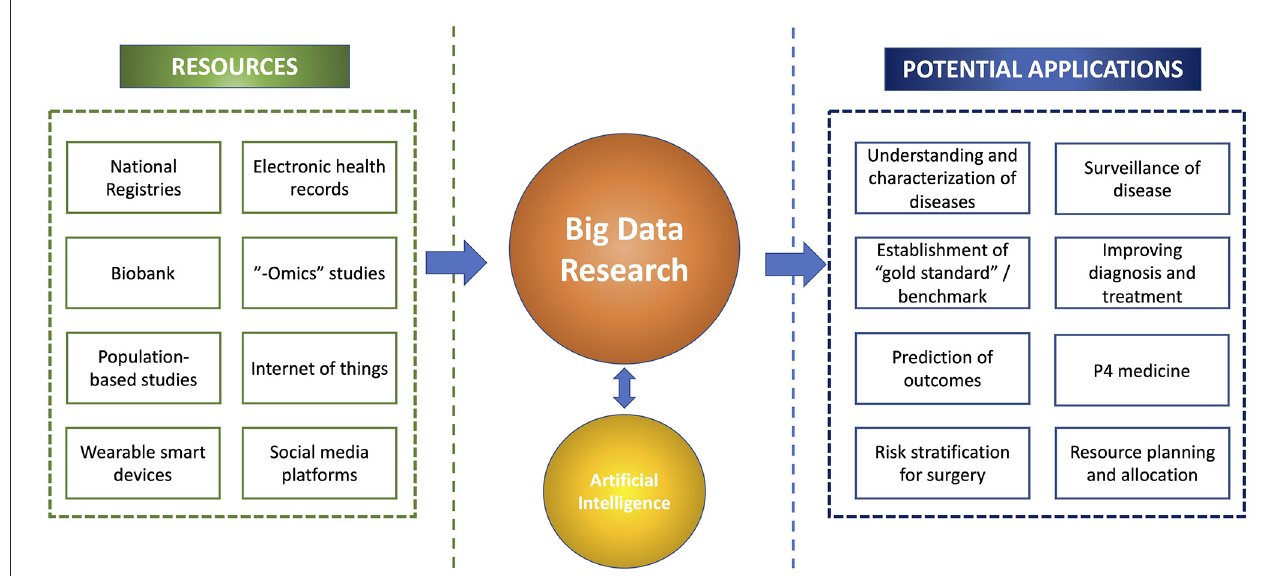
FIGURE1 An overview of the big data research, including the resources, potential synergism with artificial intelligence, and clinical applications.